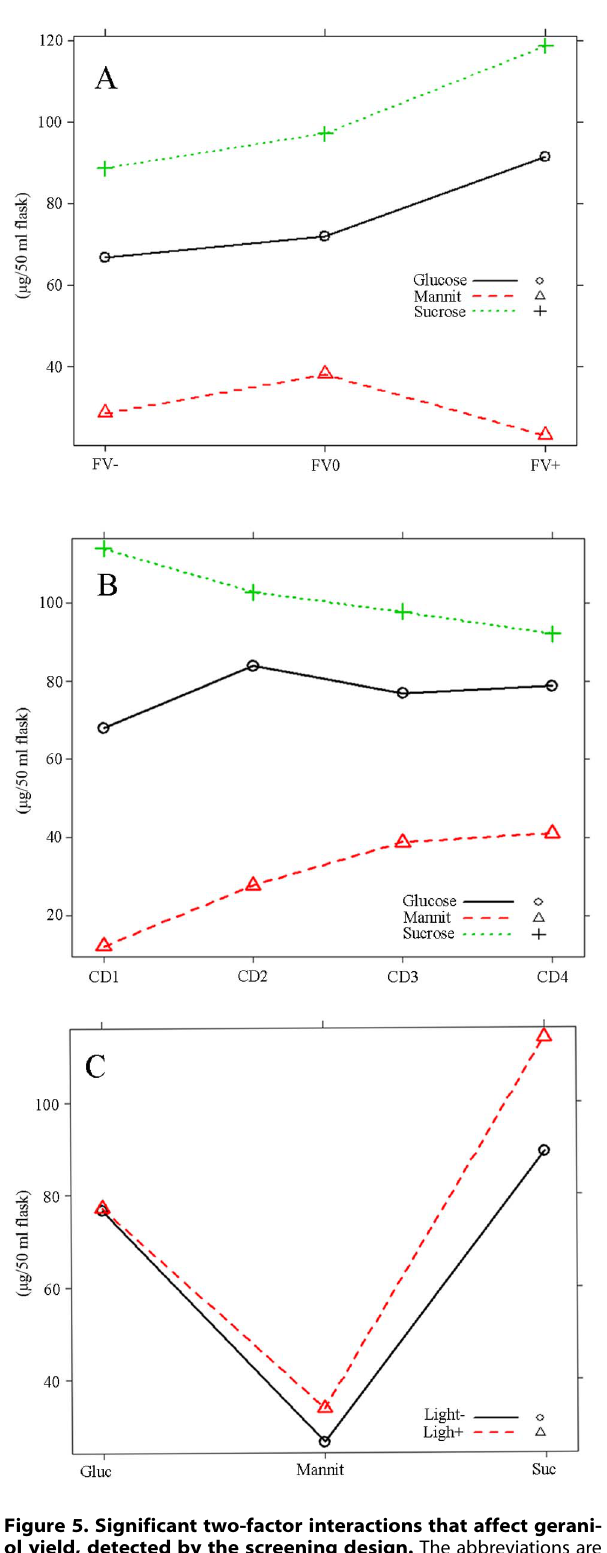
Figure 5. Significant two-factor interactions that affect gerani- ol yield, detected by the screening design. The abbreviations are the same as in Table 1. (A) Filling volume:sugar interaction. (B) Sugar:cyclodextrins interaction. (C) Light:sugar interaction.